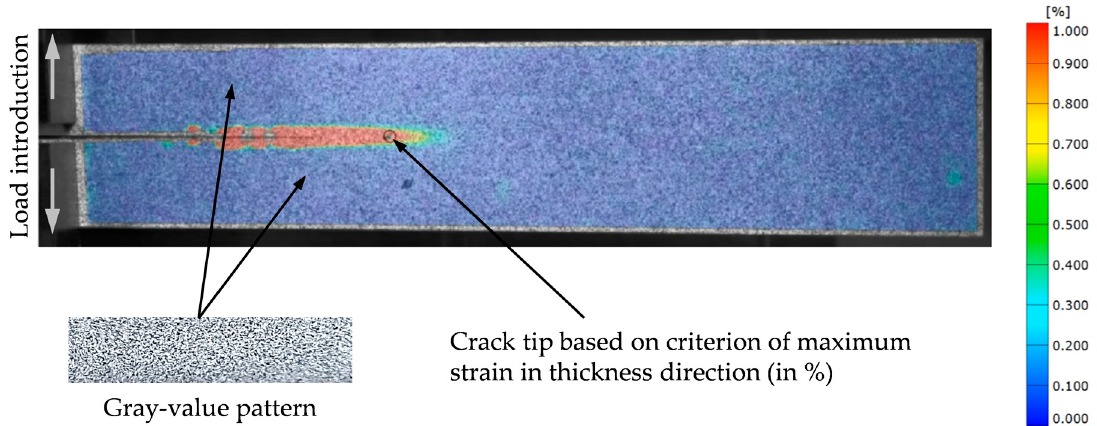
Figure 7. Evaluation of the crack propagation with Software ARAMIS.